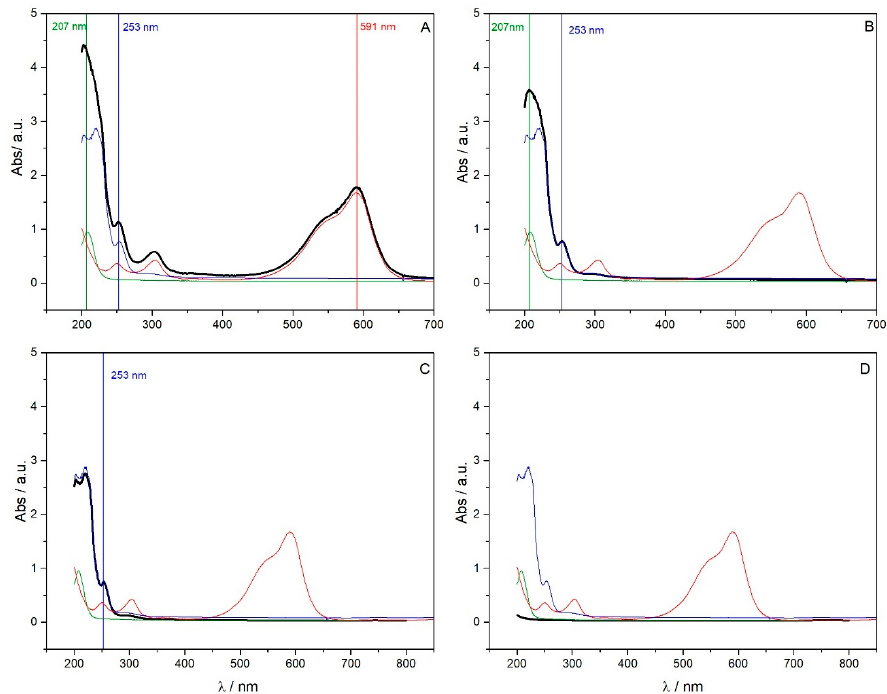
Figure 11. UV-vis spectra of a mixture (black curves) containing CV, Pb(II) and Ce(III) before ( A ) and after the treatment with K10-Mt (0.2 g · dm − 3 ) at pH 2.0 for 60 min ( B ), the subsequent treatment with K10-Mt (0.2 g · dm − 3 ) at pH 2.0 for 12 h ( C ) and after the final treatment with K10-Mt (2 g · dm − 3 ) at pH 6.0 ( D ). Red, green and blue curves are the spectra of CV, Pb(II) and Ce(III), respectively.